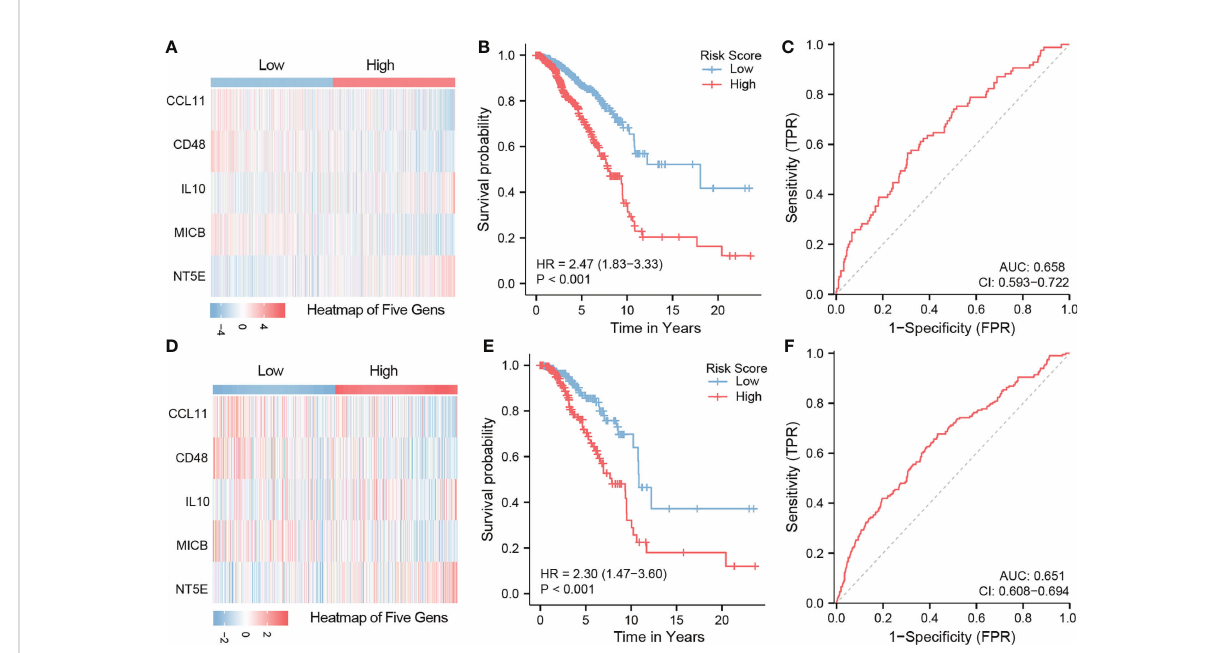
FIGURE 7 Construction of fi ve gene signature and validation. Constructed a 5 gene signature prognostic model based on the multivarite results. The high- risk group have a worse prognosis than those in the low-risk group (HR=2.47,95%CI 1.83-3.33,p<0.001). The area under the ROC curve of the model was 0.658 (A – C) . The internal validation results of the model also demonstrate that high-risk patients the poor outcome while low-risk patients a better ones(HR=2.30,95%CI 1.47-3.60,p<0.001). The area under the ROC is 0.651 in the validation group (D – F)